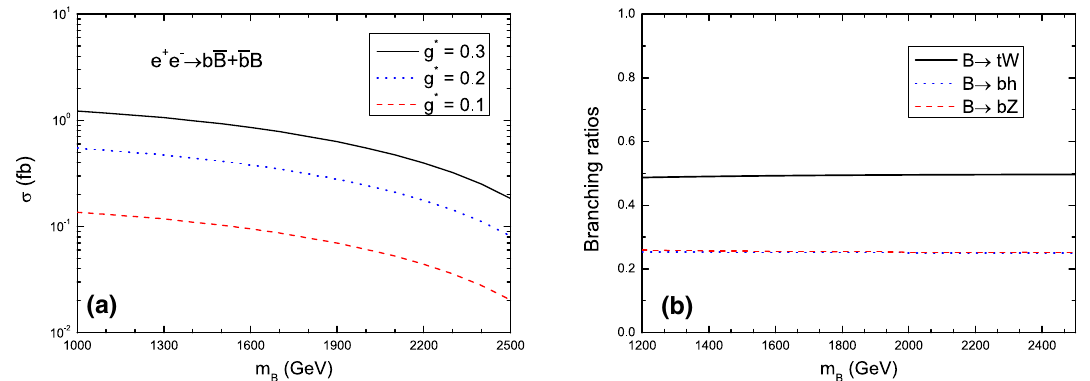
Fig. 1 a Total cross sections as a function of m B with three typical values of g ∗ . b Branching ratios for the three decay modes for various of VLQ- B quark masses with g ∗ = 0 .